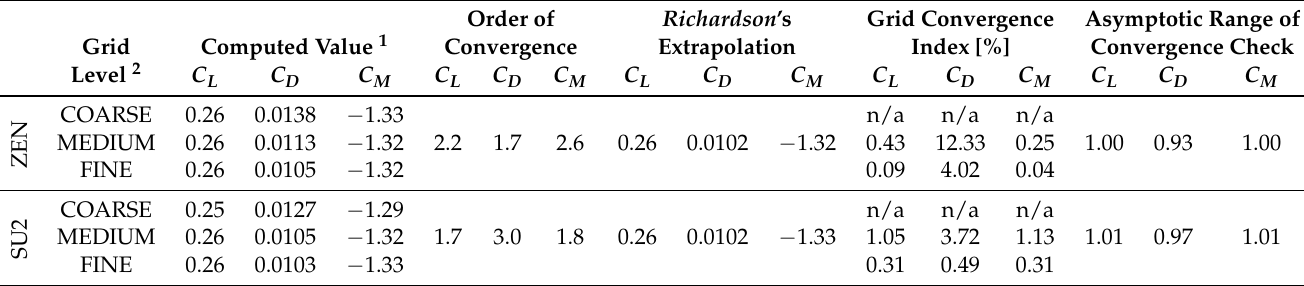
Table 4. Grid convergence data of CFD computations using Finite Volume Methods ( M =